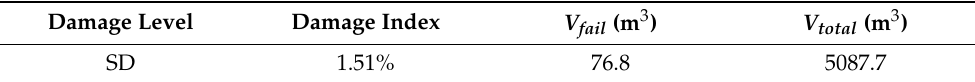
Table 4. Estimated damage level, damage index, and volume of failed elements for exterior blast scenario.